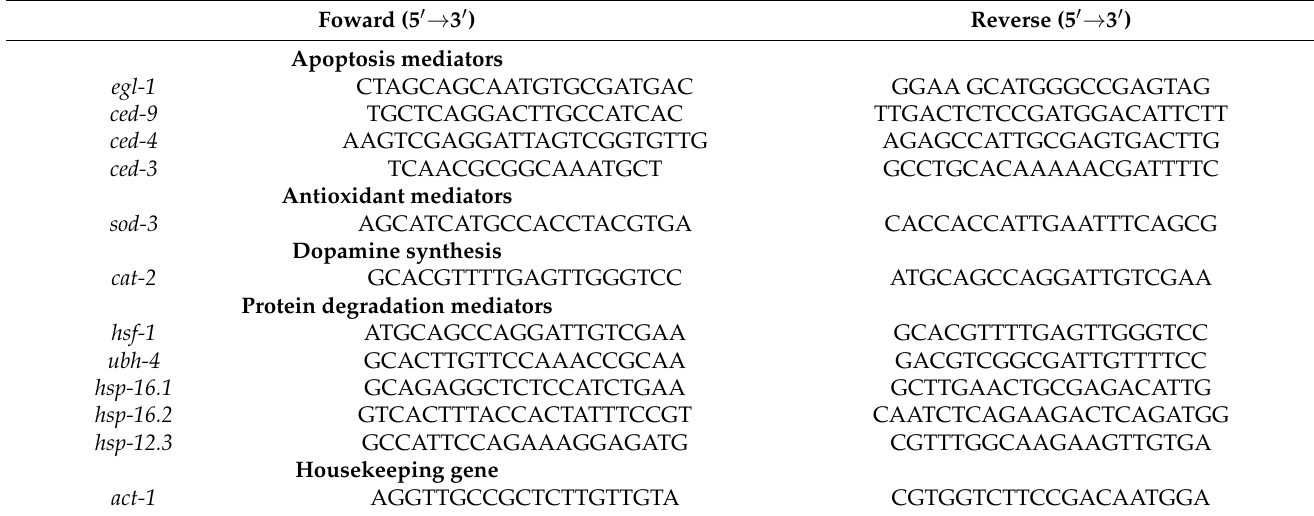
Table 3. Primer lists used in this